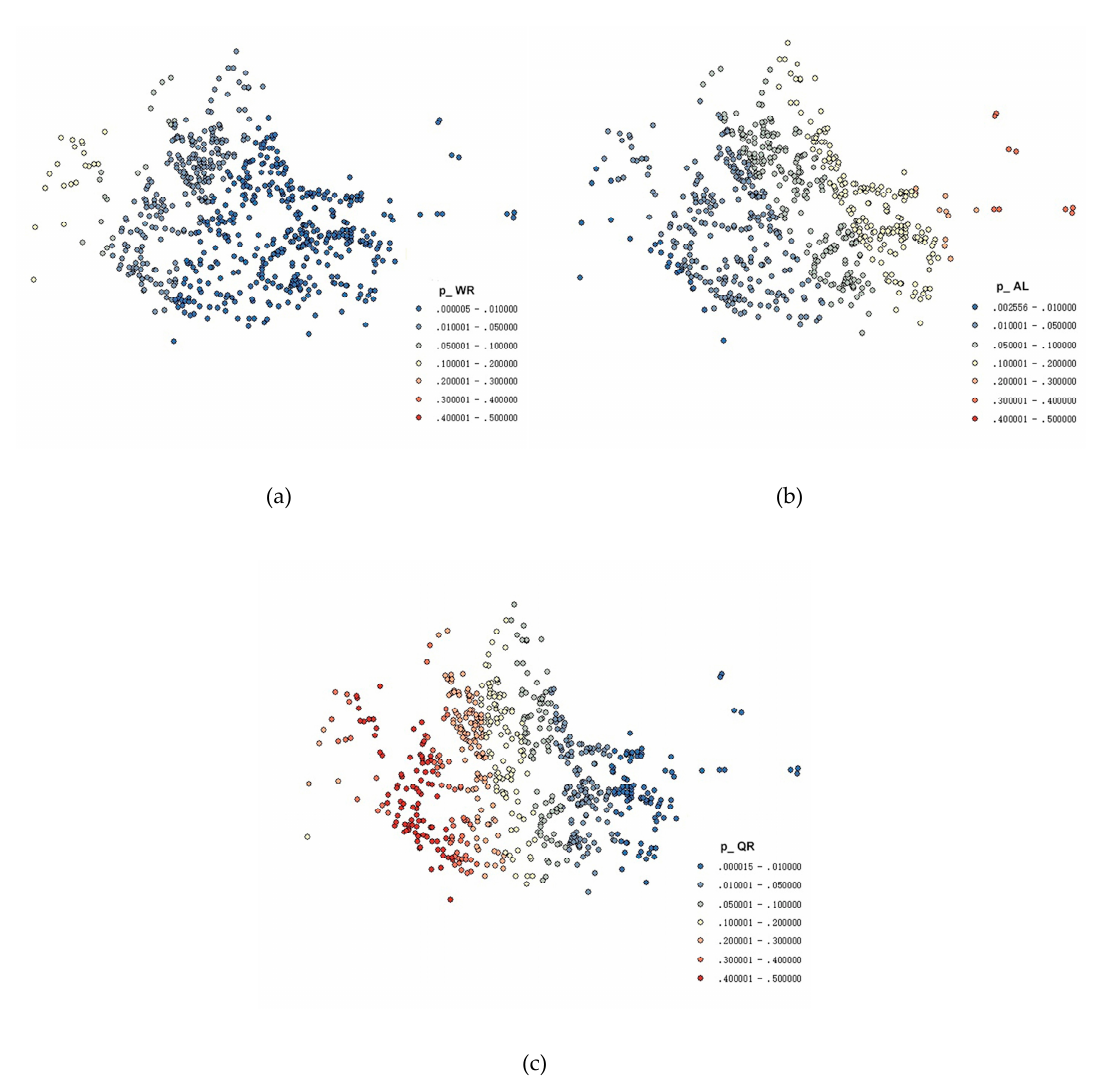
Figure 7. P-value distribution of river width ( a ), lake area ( b ) and river water quality ( c ).